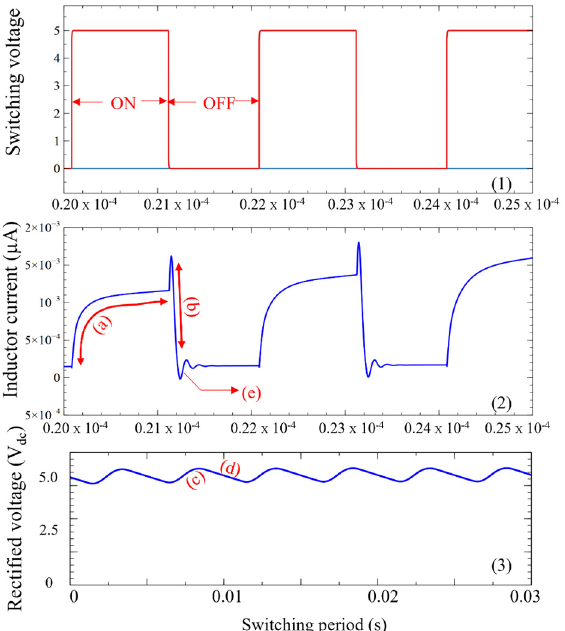
Figure 10. Zoom-in view of the switching period ( 1 ) Switching, ( 2, 3 ) Inductors and load capacitor energising process, ( a ) Mode 2, ( b , c ) Mode 3, ( d ) Mode 4, ( e ) Inductor leakage current.